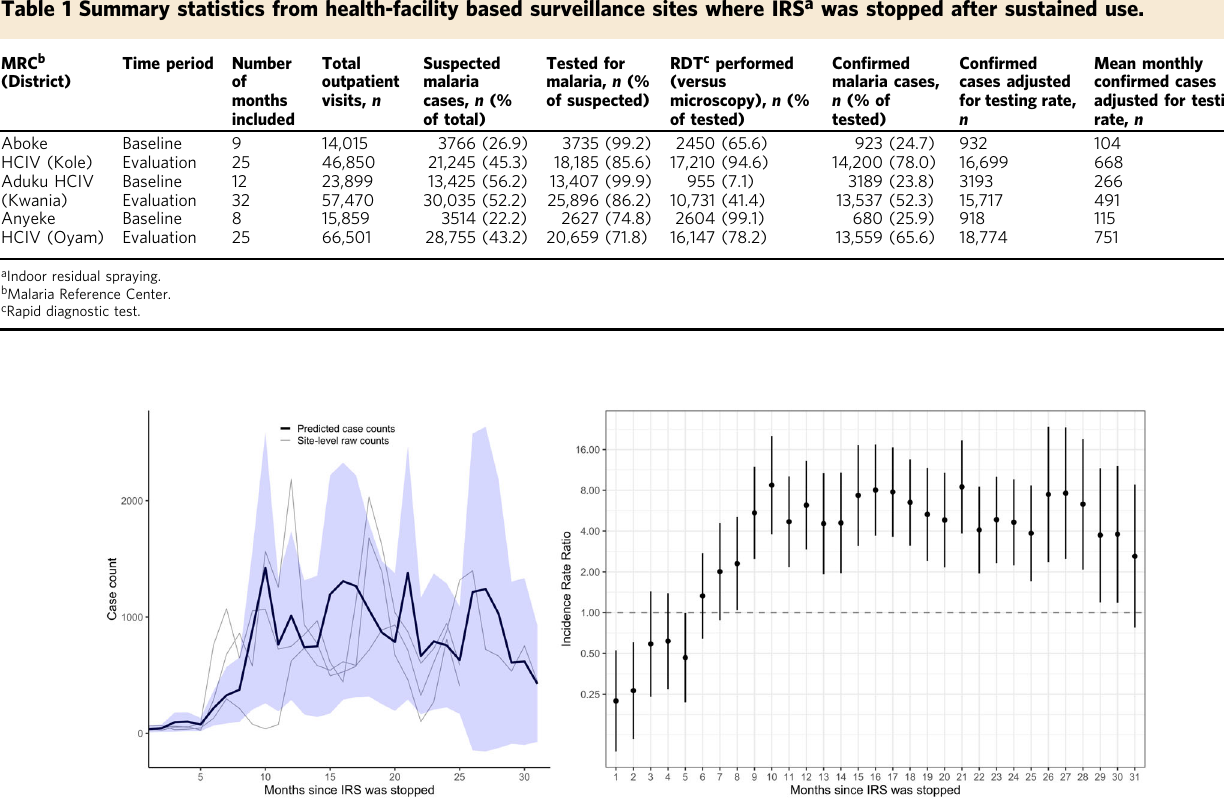
Table 1 Summary statistics from health-facility based surveillance sites where IRS a was stopped after sustained use.